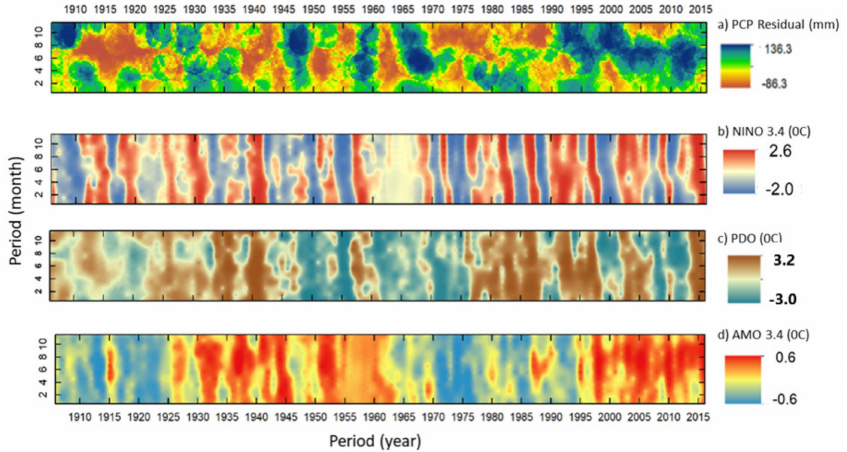
Figure 5. Year–month matrix map of ( a ) monthly rainfall deviation from the long-term average rainfall of the corresponding month, ( b ) NINO 3.4, ( c ) AMO, and ( d ) PDO indices. The vertical axis refers to months from January (1) to December